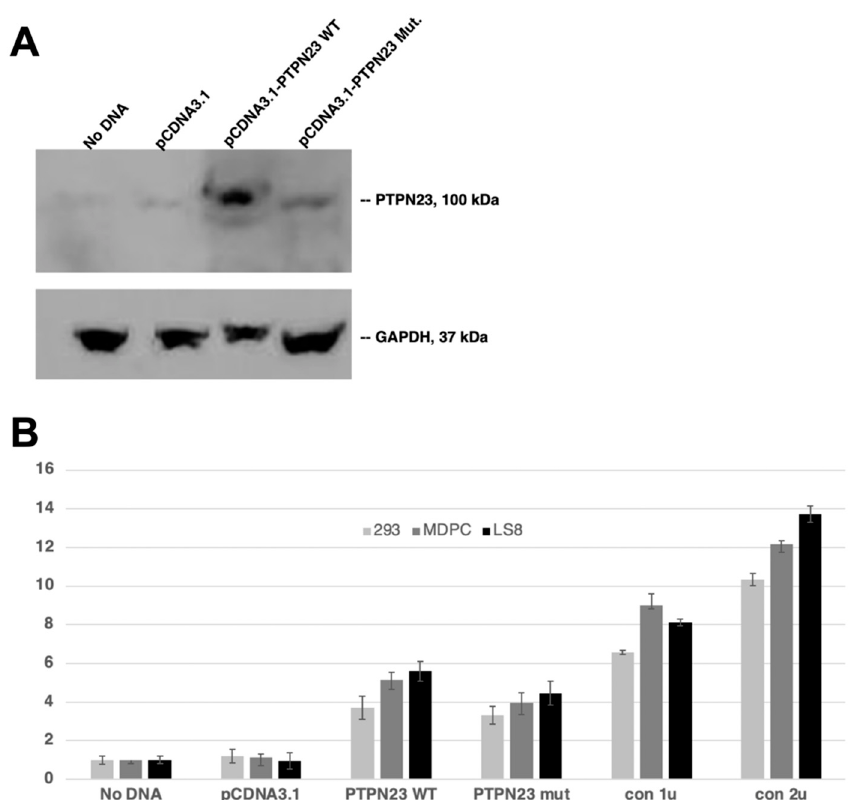
Figure 9. PTPN23 mutant protein has reduced phosphatase activity. ( A ) Cell lysates from transfected and untransfected cells were probed for PTPN23 expression. Both untransfected and control transfected cells showed low levels of endogenous PTPN23 protein expression. WT and mutant PTPN23 transfected lysates showed increased expression (n = 3). ( B ) Phosphatase activity was measured after no transfection and transfection of control DNA, WT PTPN23, and mutant PTPN23 (Glu603Lys). Three different cell lines were used to measure phosphatase activity: HEK293, MDPC (dental pulp cells), and LS-8 (oral epithelial cells). WT PTPN23 has low phosphatase activity in the three cell lines, compared to Potato Acid Phosphatase controls with either 1 unit (u) or 2 units. However, mutant PTPN23 has decreased phosphatase activity compared to WT PTPN23 (n = 3).